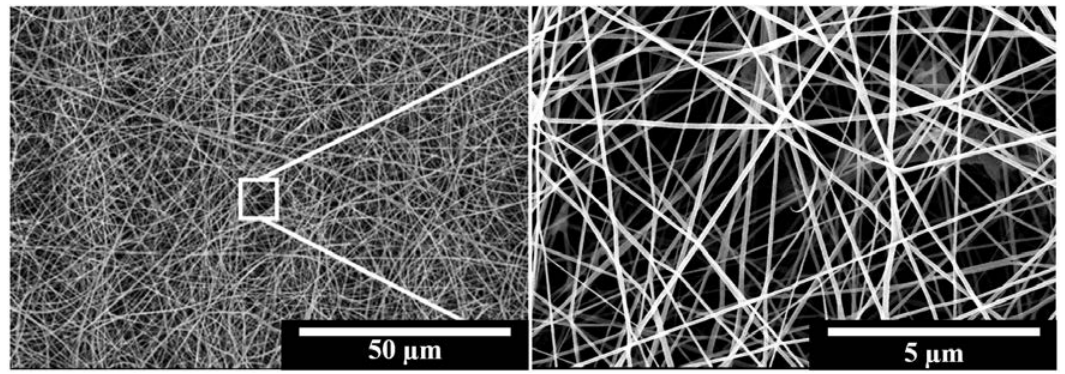
Figure 5. SEM images of the IMQ-PCL nanofibrous mesh prepared using the optimised parameters (i.e., 30 wt % polymer solutions, 20 kV applied voltage, 18 G capillary).